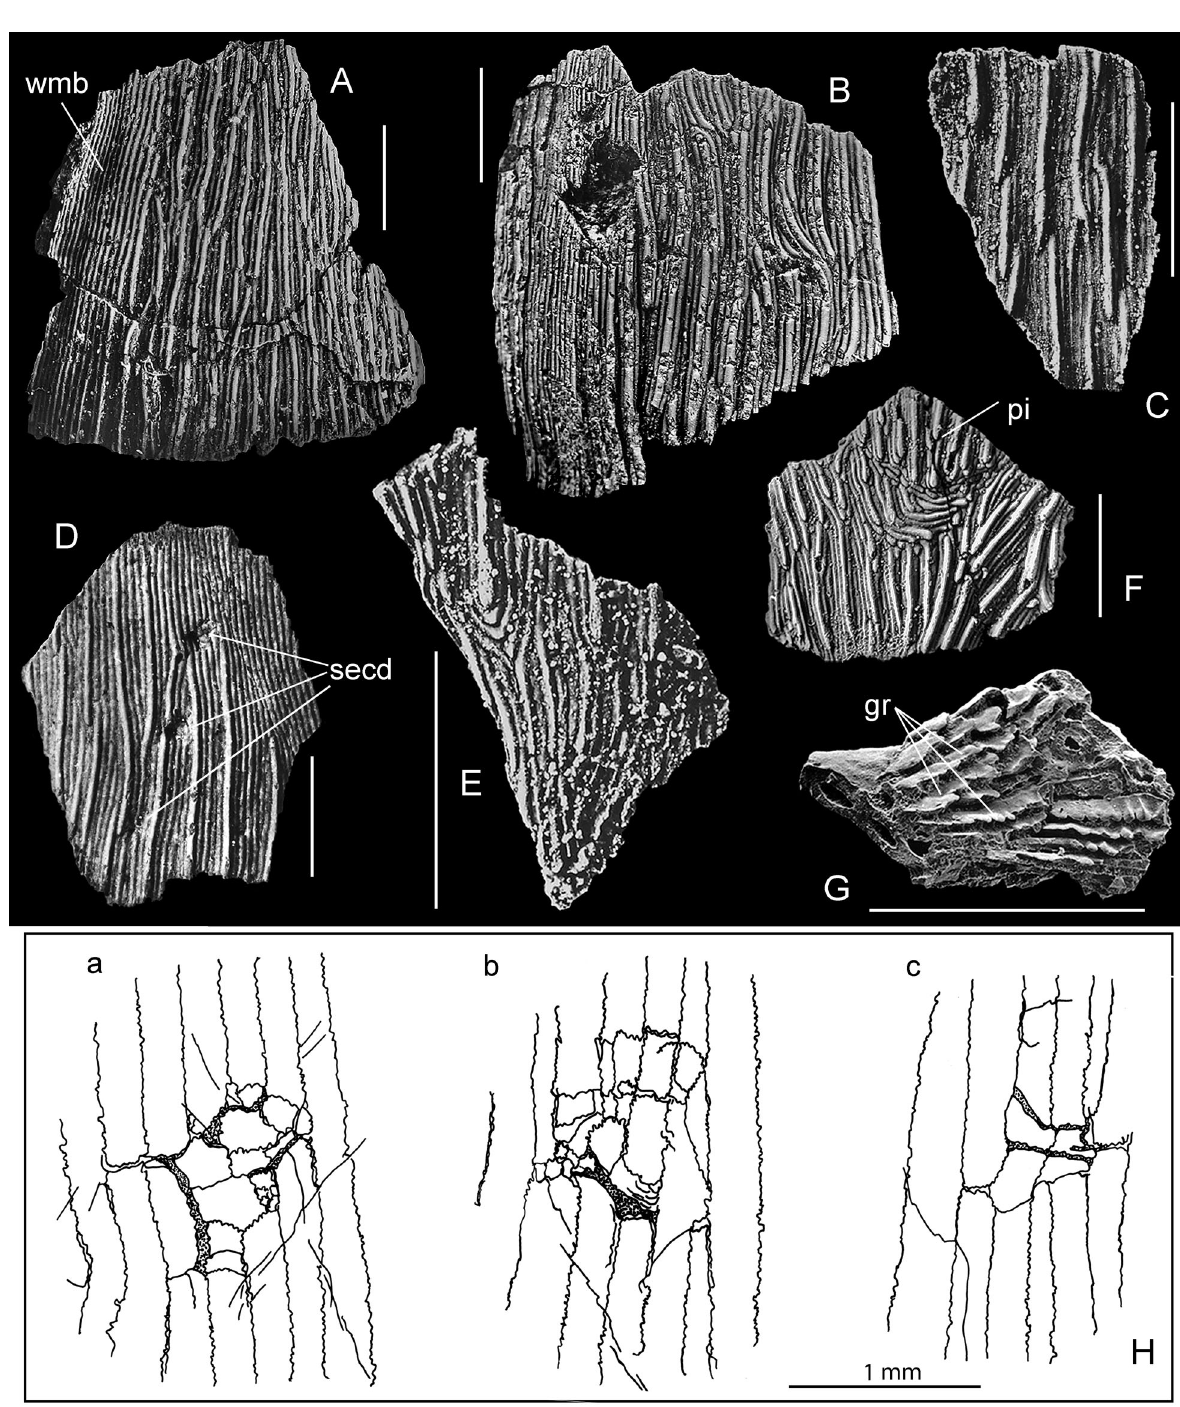
Fig. 8. Cyathaspis alexanderi sp. nov. A–F : A, holotype, a big fragment from the right side of the ventral shield, GIT 408-14; B, fragment possibly from the dorsal shield, GIT408-15; C, D, shield fragments of unknown position on the body, D, with healed bite marks, GIT 408-16 and GIT 408-17; E, small piece of possibly the dorsal shield, GIT 408-18; F, fragment from the midline of the dorsal shield, most possibly from the pineal area, GIT 408-19; G , Cyathaspididae gen. et sp. indet., the element of the possibly branchial region, GIT 408-20; H , bite marks in D (a, the anteriormost, followed by b and c) with small tubercles and a deeper groove on the bottom of each pit. Scale bars = 3 mm (A–F); 1 mm (G). Locations : A, C–G, locality 85-042; B, locality 85-146-5D, Tabuska (Vishnevaya Gora) section, the Central Urals, Tabuska Beds either of the lower P ř idoli (Shujskij 1981; Shurygina et al. 1981) or upper Ludlow level (Modzalevskaya & Märss 1991). Abbreviations : gr, possible gill rakers; pi, possibly pineal macula; secd, secondary denticles in the healed wounds; wmb, wide marginal band of uniform